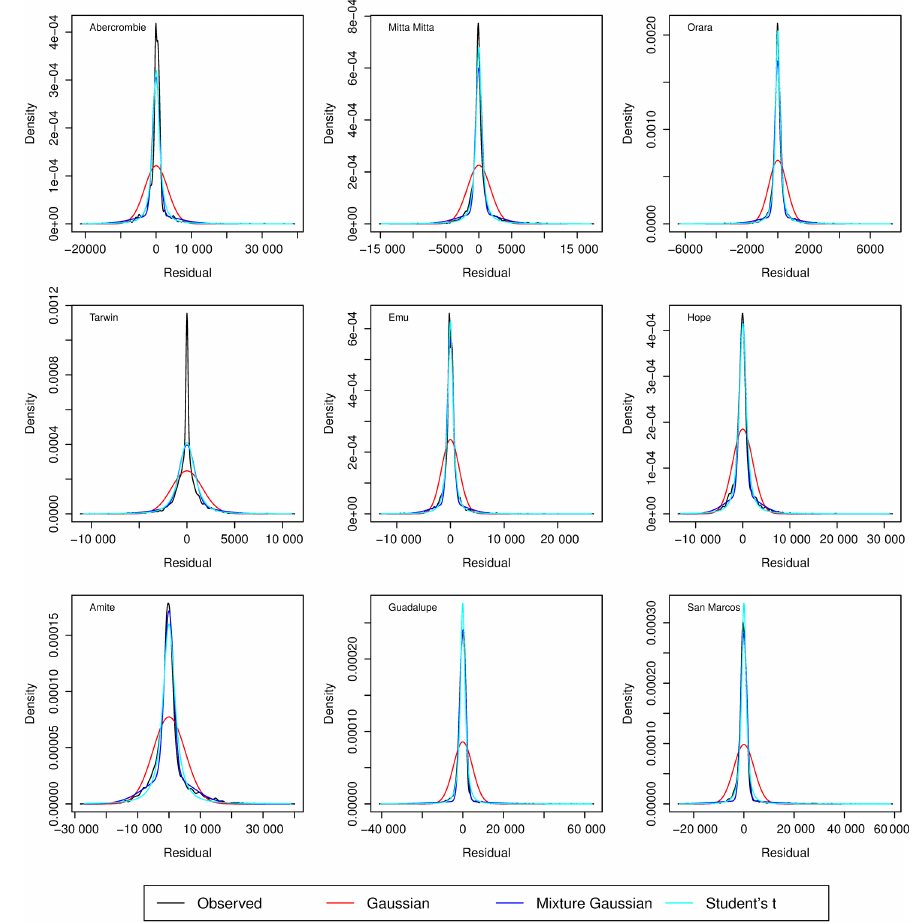
Figure 5. Comparison of the different probability density functions fitted to the model residuals at Stage 3 for each